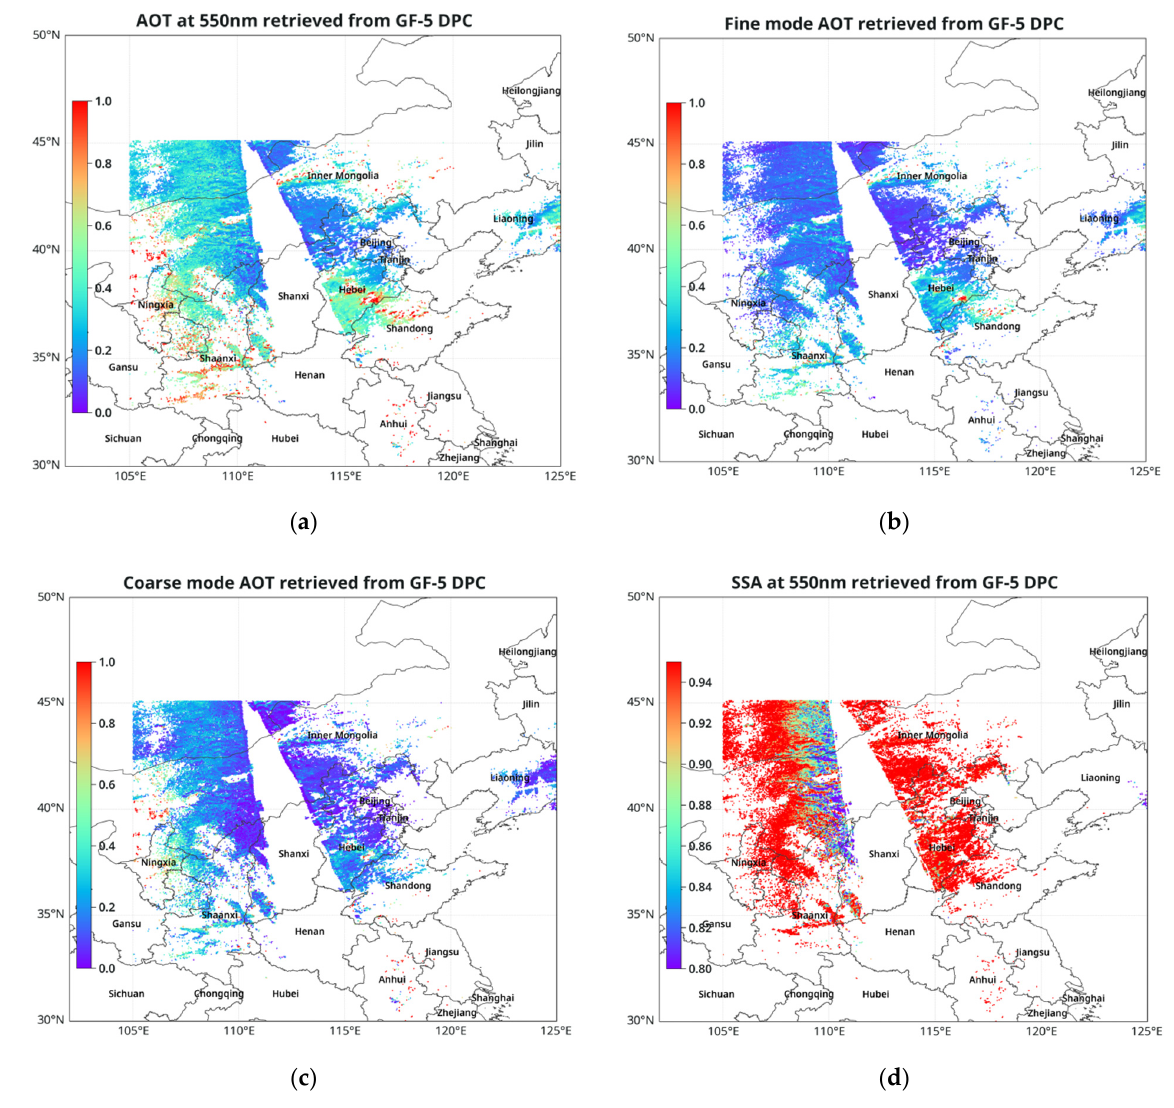
Figure 8. The aerosol retrievals with DPC over northern China on 13 March 2020, including the ( a ) AOD; ( b ) fine mode AOD; ( c ) coarse mode AOD and ( d ) SSA.